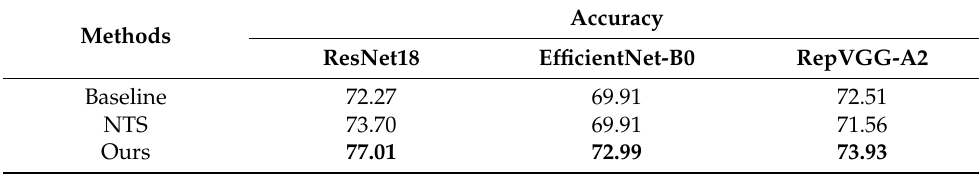
Table 6. Comparison of the proposed method and NTS